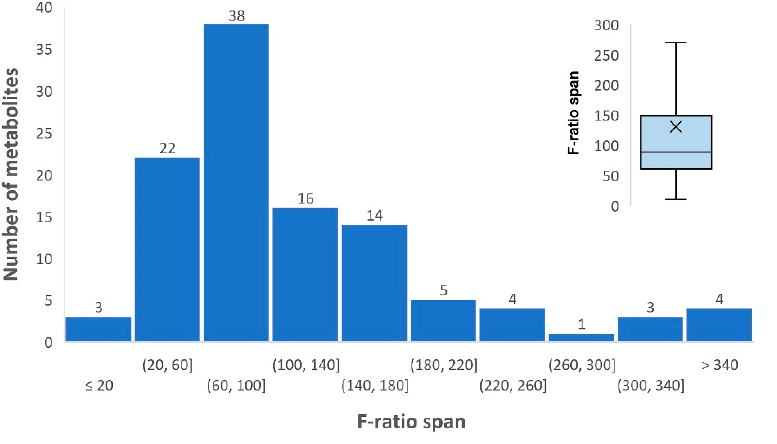
Figure 4. Distribution of F-ratio values for detected metabolites presented as the histogram and box-and-whiskers plot. The day of sampling serves as the X coordinate. The value along the Y axis is the normalized signal intensity m/z of the feature of the selected metabolite. Most of the metabolites (97%) have an F-ratio > 20, which characterizes the observed changes that we observed within 20 days as statistically significant since the critical value of F-ratio (alpha = 0.05, df1 = 5, df2 = 2) = 19.3. The cross inside the rectangle of the box-and-whiskers plot shows the mean of the F-ratios for the metabolites, and the horizontal line inside the box is the median. The horizontal dashes at the end of the “whiskers” indicate the maximum and minimum F-ratio values, excluding outliers.